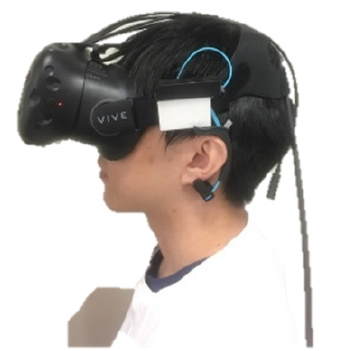
Figure 2. The VR HMD with the attached EEG sensor .